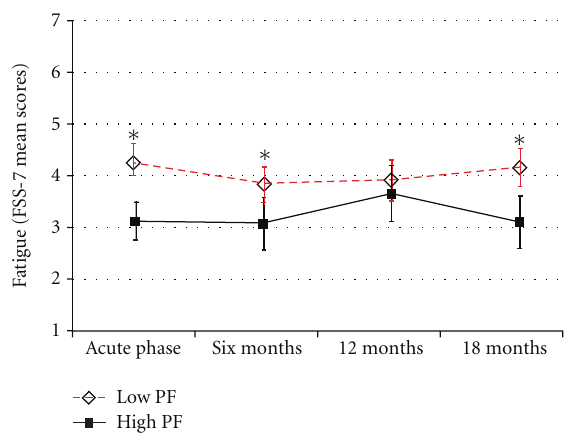
Figure 3: Time course for fatigue by patients with low physical functioning (PF) ( n = 61) versus those with high PF ( n = 33). Ad- justed for level of depression and prestroke fatigue. Bars are lower and upper 95%